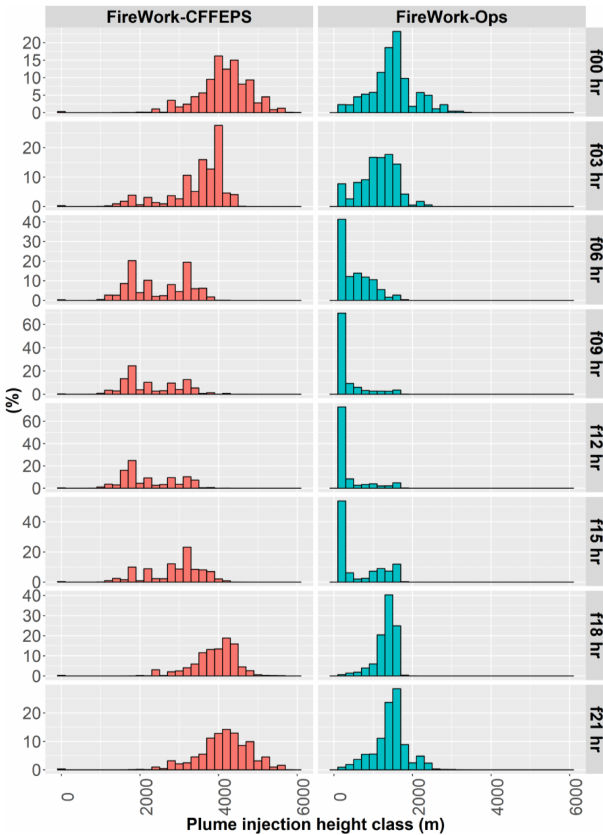
Figure 6. Modelled plume injection height frequency distribu- tion by 200m altitude intervals for all fires in British Columbia, Canada, in August 2017 by forecast hour for 00:00UTC forecasts by FireWork–CFFEPS (left) and FireWork-Ops